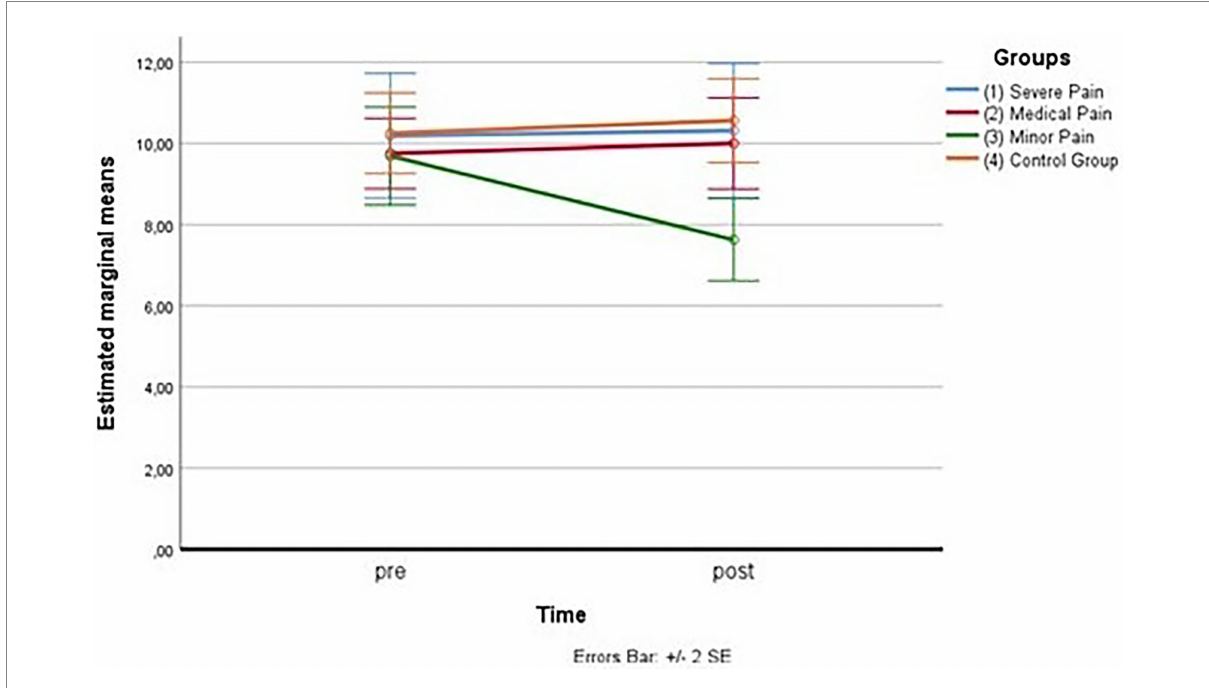
FIGURE 7 Estimated marginal means for the fear of minor pain.